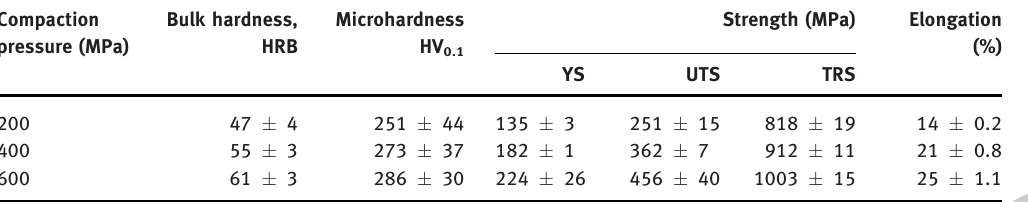
Table 3: Effect of compaction pressure on the mechanical properties of 316L stainless steel sintered at 1,400°C. Compaction pressure (MPa)